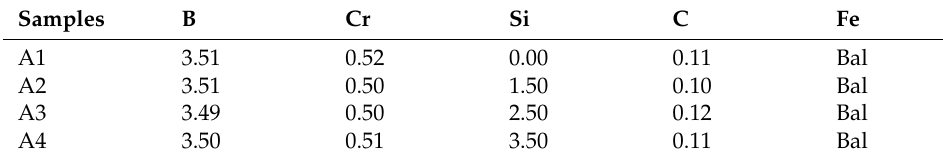
Table 1. Chemical compositions of cast DS Fe–B alloy by spark emission spectrometer (wt.%). Samples